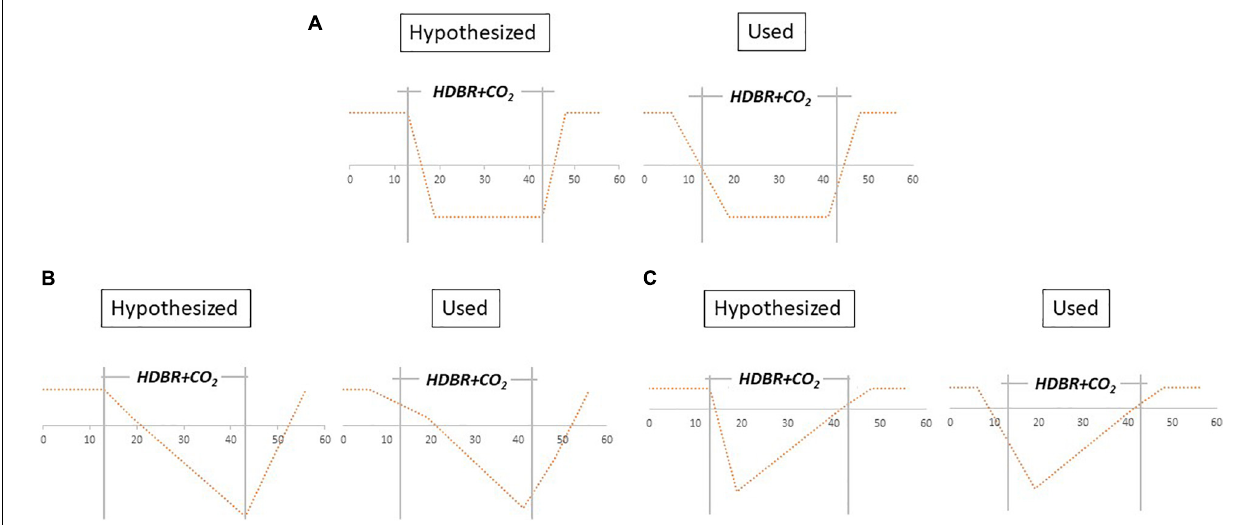
FIGURE 3 | Hypothesized models vs. tested contrast vectors. (A) Instant decrease, (B) cumulative decrease, and (C) instant decrease with recovery in- HDBR + CO 2 . Models were also applied for instant increase, cumulative increase, and instant increase with recovery in- HDBR + CO 2